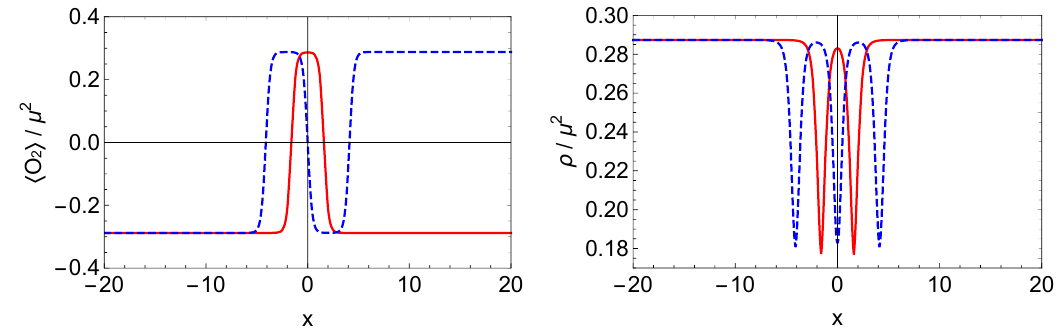
Figure 9 . The condensate (left) and the charge density (right) pro(cid:12)les obtained from each bulk solution with two (dashed line) or three nodes (solid line) for (cid:22) = 8 and L = 40. These solutions correspond to the multi-kink